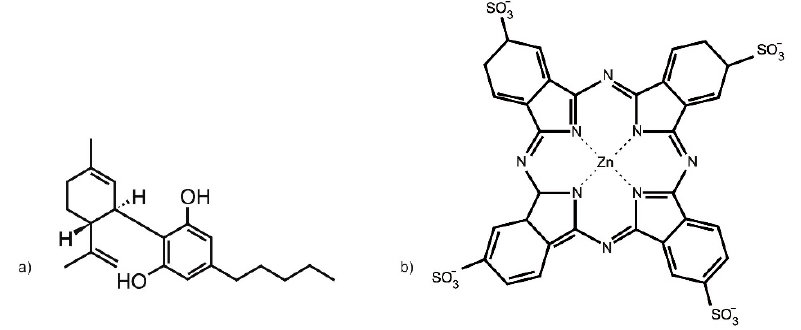
Figure 9. ( a ) Chemical structure of CBD. ( b ) Chemical structure of ZnPcS 4